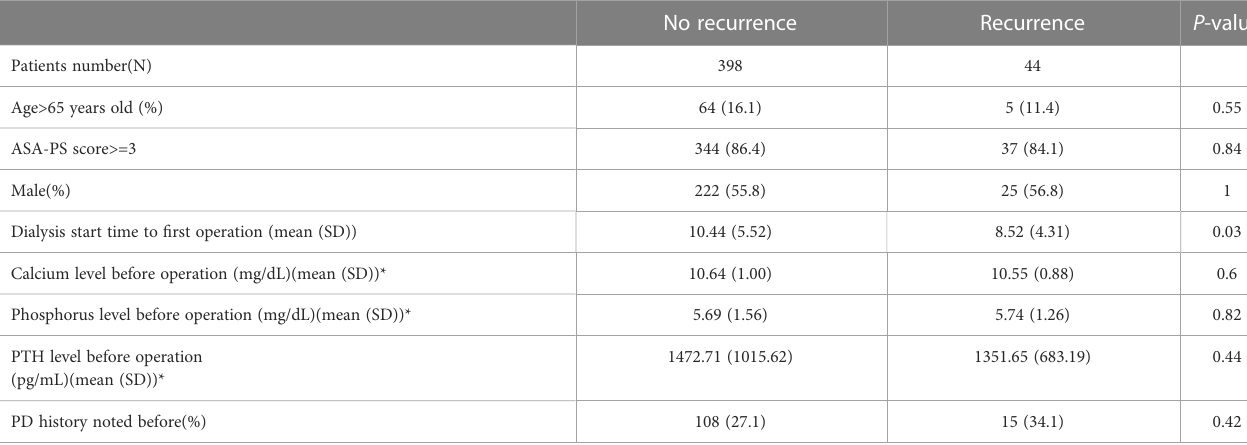
TABLE 1 Demographic data of the patients for analysis of recurrence (N=442).